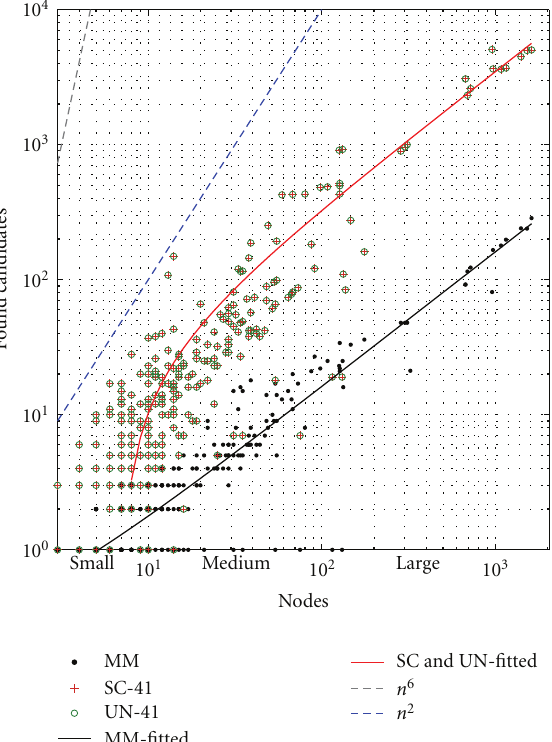
Figure 4: Runtimes of the ISE identification algorithm for di ff erent basic block sizes (nodes). The SC: SingleCut, UN: Union, MM: MaxMiso algorithms. The label “41” means that the SC and UN search has been constrained to 4 inputs and 1 output.